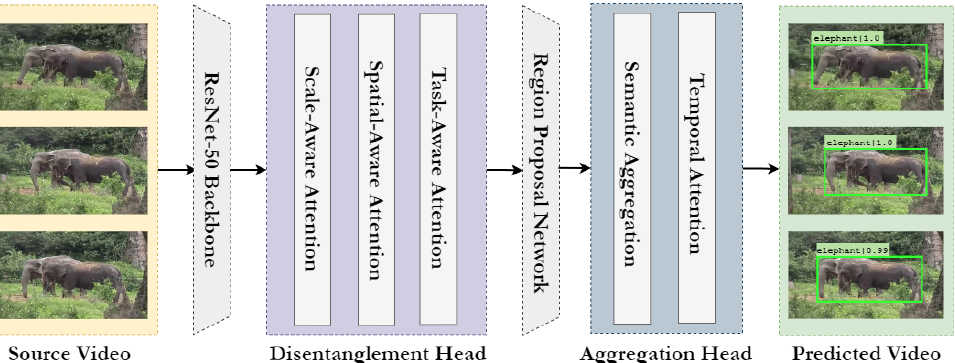
Figure 3. Overview of the proposed object detection framework based on the Faster R-CNN architec- ture. The figure highlights the modules with their components and illustrates the sequence in which the data is